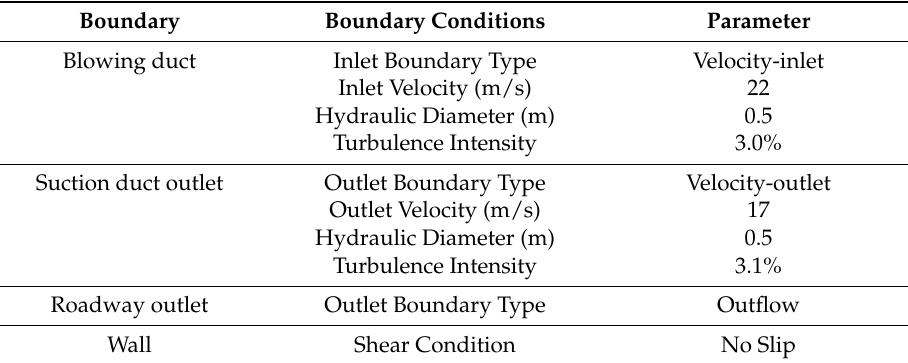
Table 3. Boundary conditions.